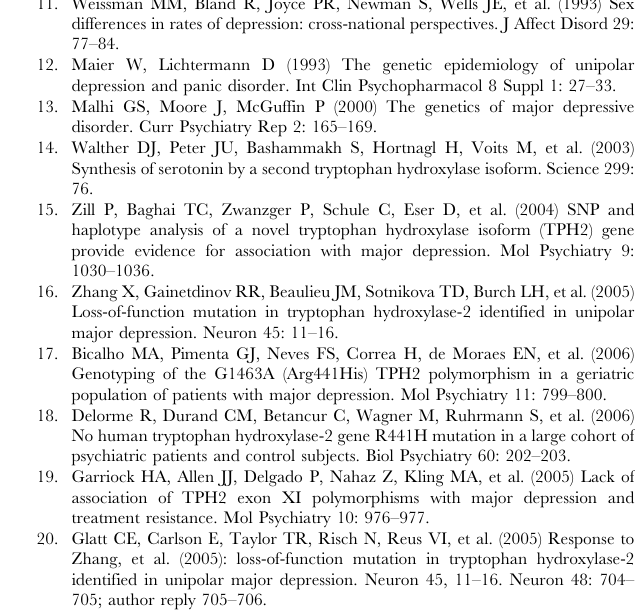
Table S1 Summary of stydies of major depression and